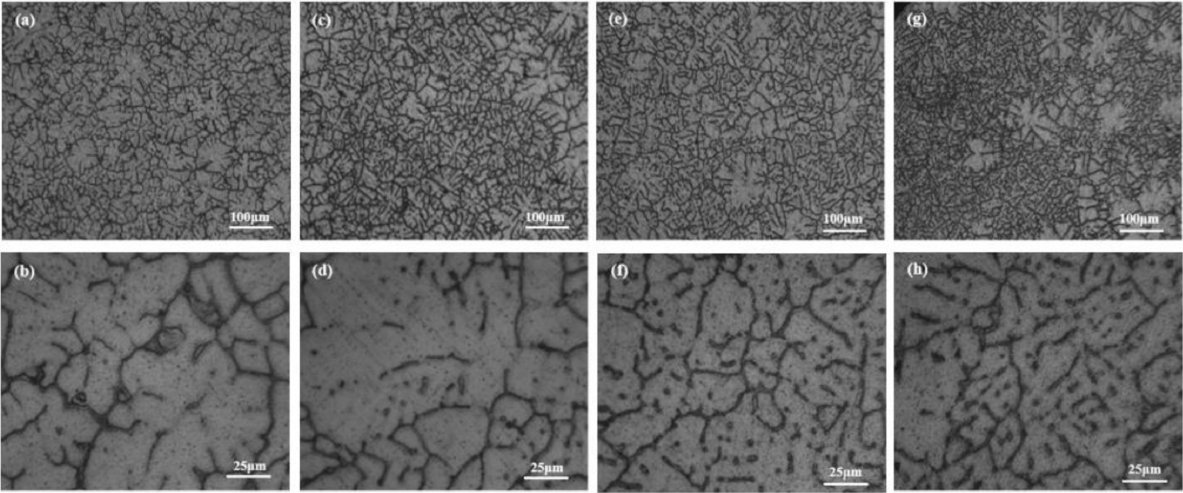
Figure 2. OM (optical microscope) images of alloys with different Zr content: ( a , b ) Alloy A: 0.10%; ( c , d ) alloy B: 0.15%; ( e , f ) alloy C: 0.20%; ( g , h ) alloy D: